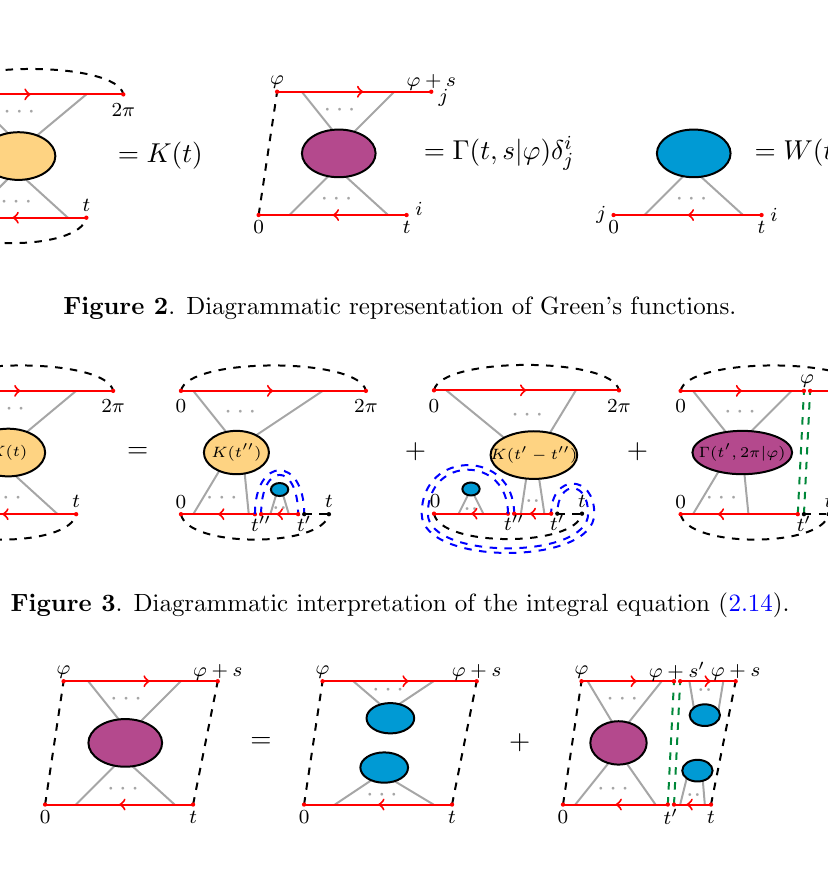
Figure 4 . Diagrammatic interpretation of the integral equation